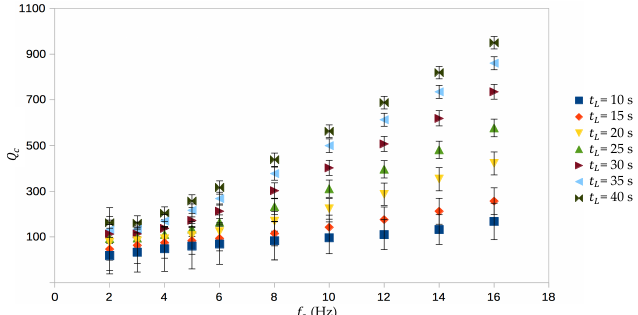
Figure 5. Average 𝑄 ! versus 𝑓 ! at all the 𝑡 % . The error bars quantify the average percentage errors on 𝑄 ! . Figure 5. Average Q c versus f c at all the t L . The error bars quantify the average percentage errors on Q c . Taking the logarithm of Equation (3), we get: